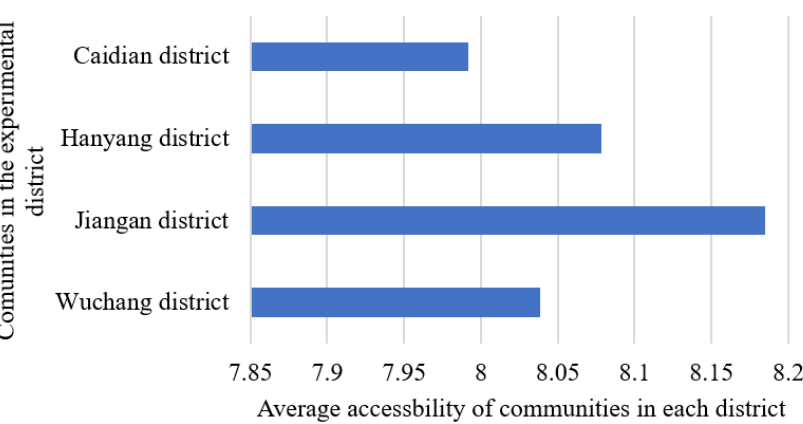
Figure 10. Average accessibility of communities in each district.